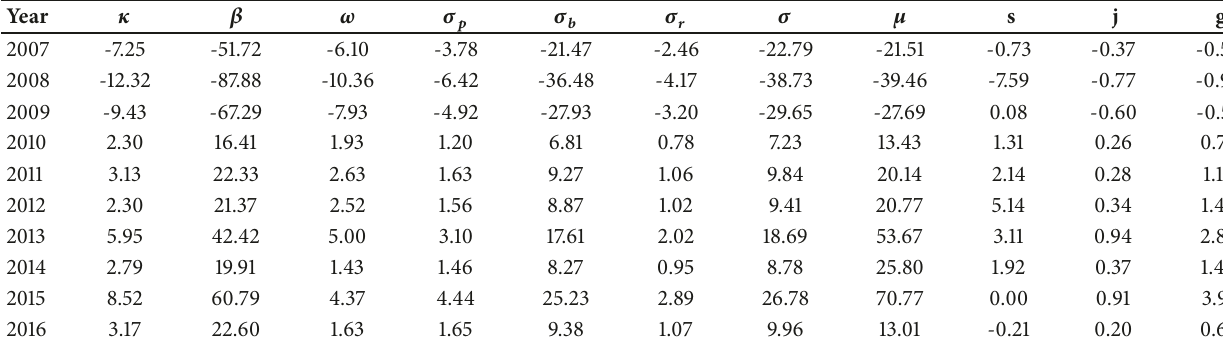
Table 4: Parameters for the Nigeria net worth